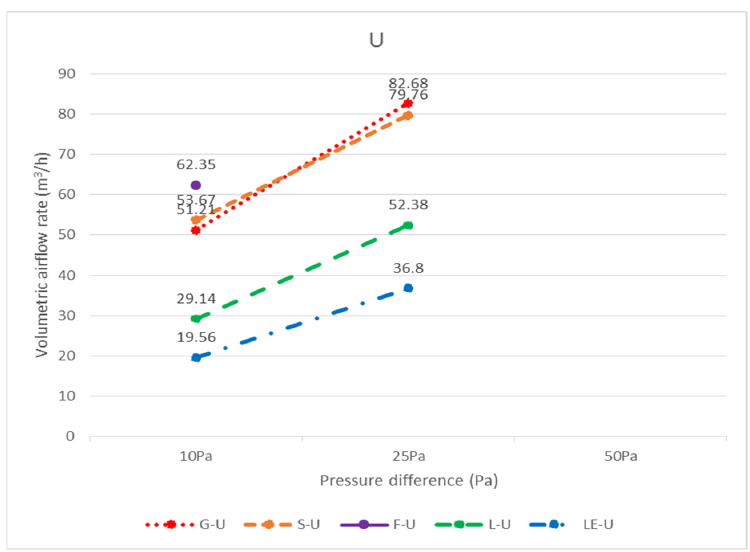
Figure 11. Average leakage of each specimen at each pressure difference from bottom to top (U) (m 3 /h).